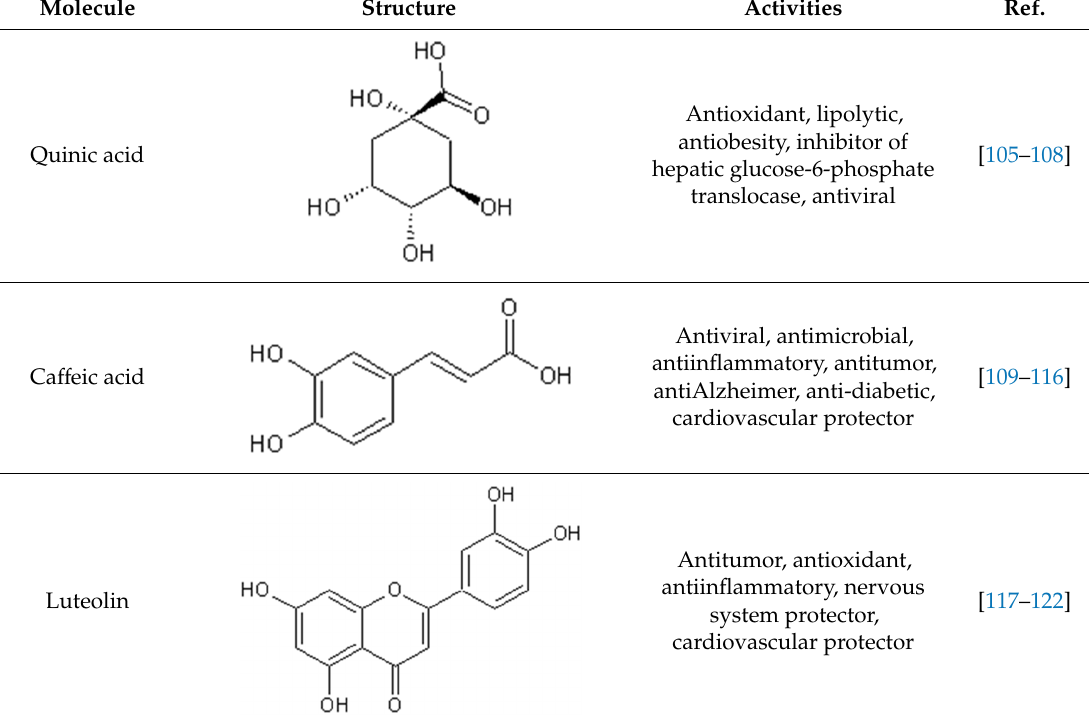
Table 3. Structure and chemical activities of major phenolic compounds present in Artemisia annua . Molecule Structure Activities